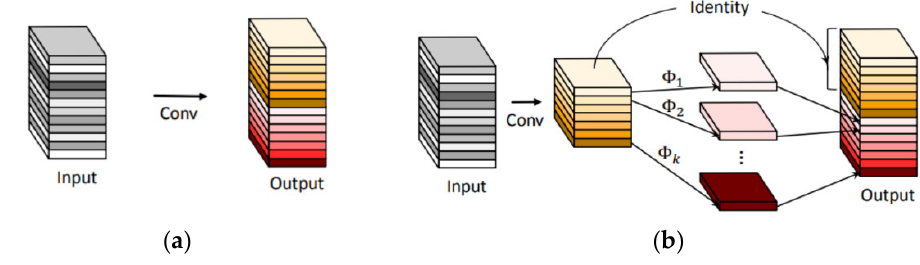
Figure 3. ( a ) Convolutional layer; ( b ) Ghost module.